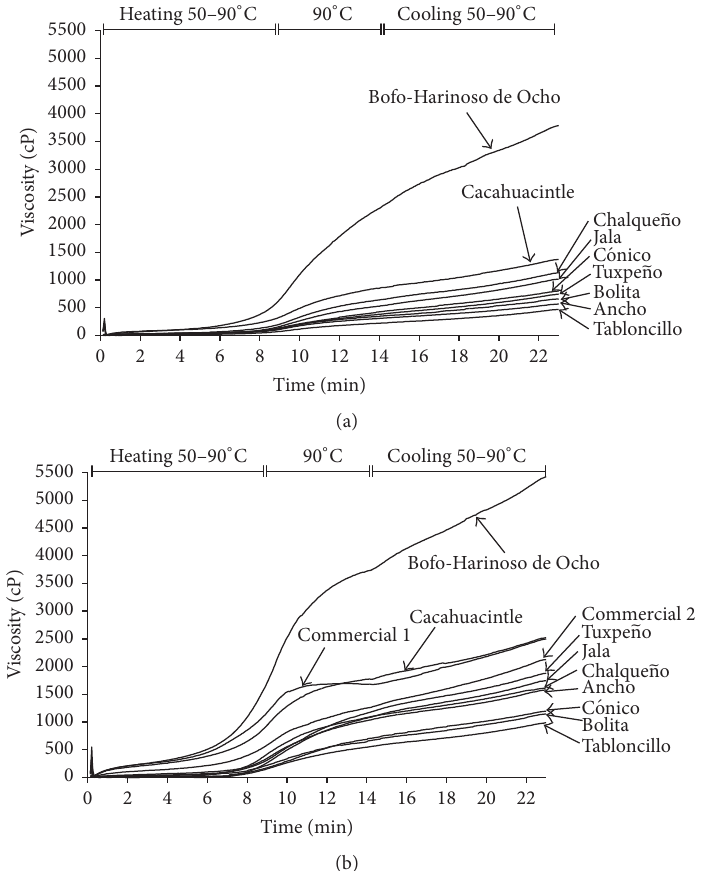
Figure 3: Viscoamylographic curves of flowered grains from nine maize landraces and commercial samples. (a) Traditional process. (b) Industrial